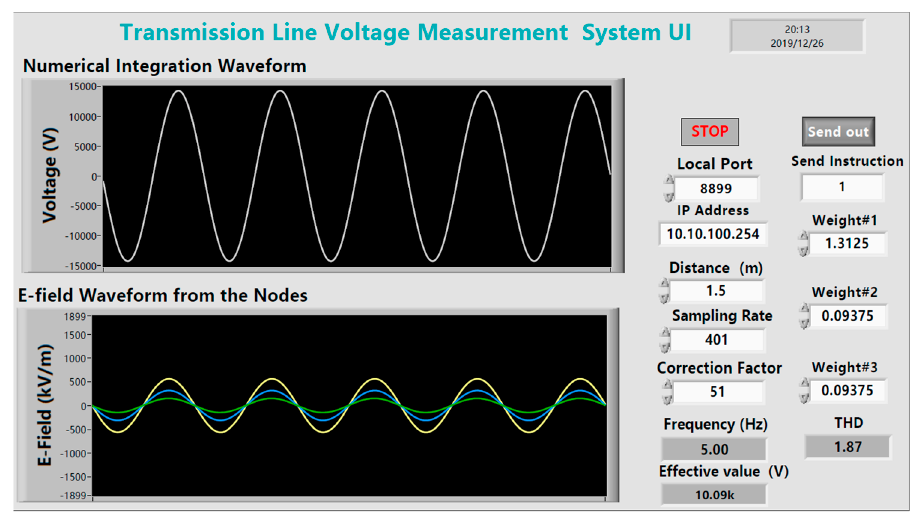
Figure 12. Measurement results displayed in the LabVIEW UI.